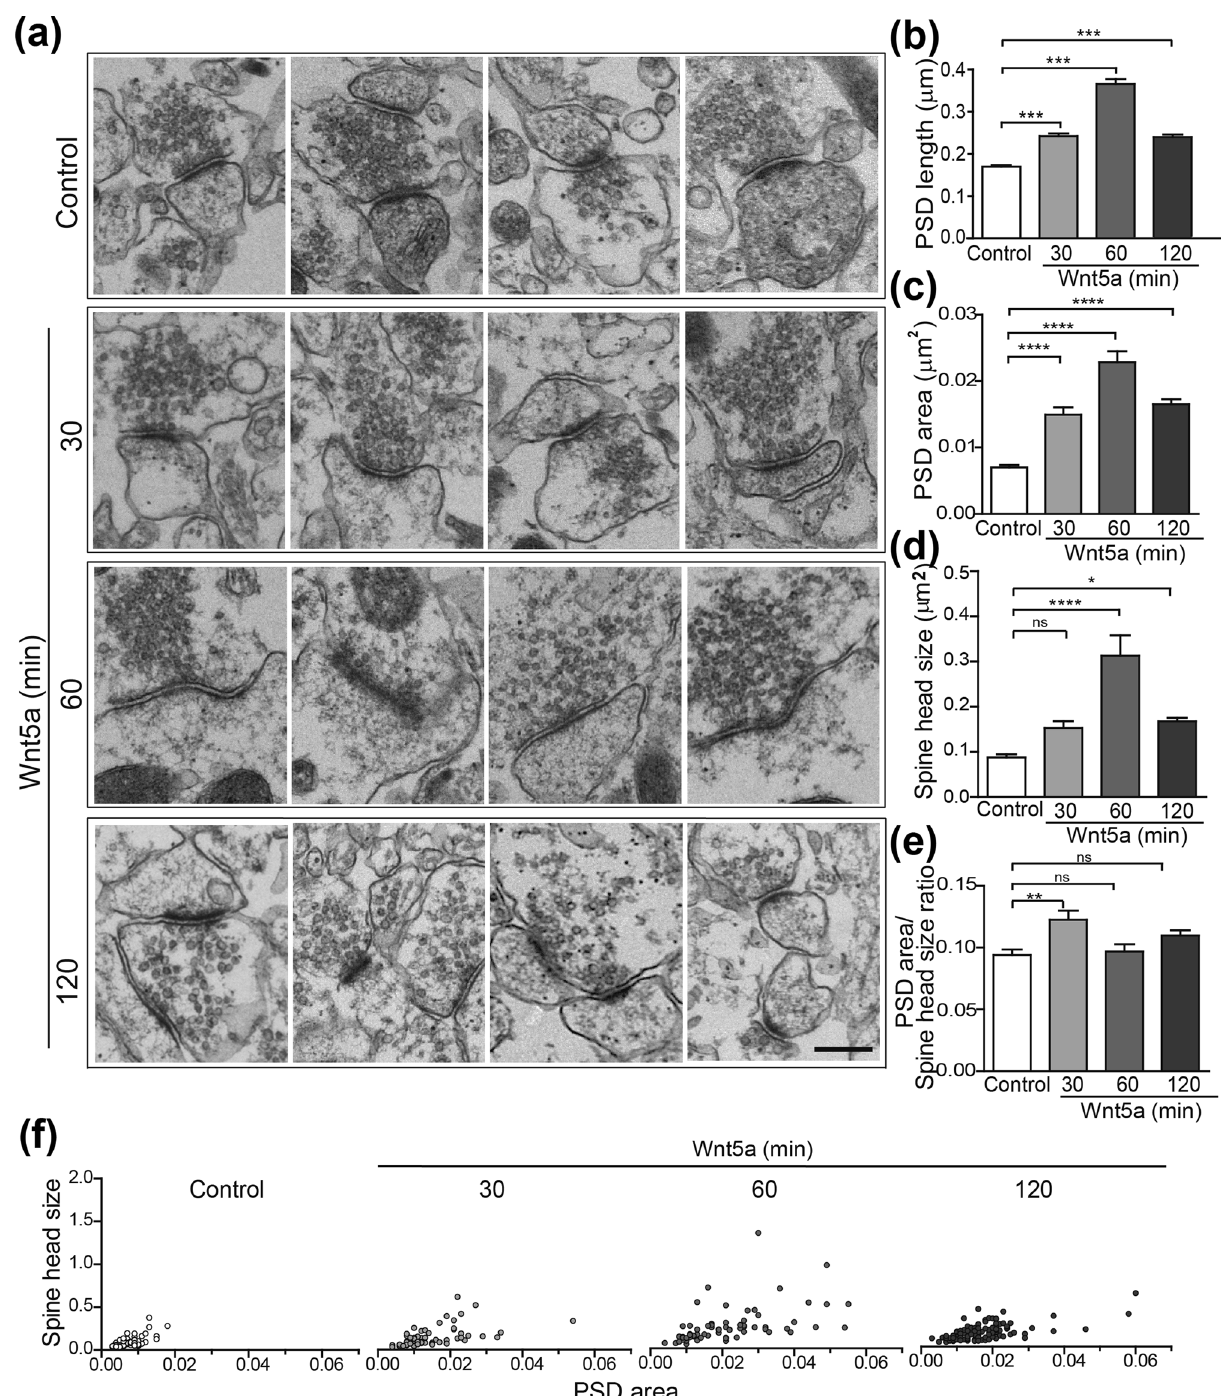
Figure 1. Wnt5a increases the PSD length in hippocampal slices. ( a ) EM images from the CA1 region of hippocampal slices exposed to Wnt5a conditioned medium for 30, 60 and 120 min. Scale bar = 250 nm. We include 4 different images for each condition. Wnt5a induced a time-dependent increase in the average PSD length ( b ) and area ( c ) in dendritic spines, with a reduction at 2 h. The spine head size was increased after 30 to 120 min of Wnt5a exposure ( d ) and the PSD area/spine size ratio ( e ) was induced at 30 min of Wnt5a treatment. N = 3 independent animals; Control (368); 30 (291); 60(247); 120(371) synaptic contacts. (*** p =